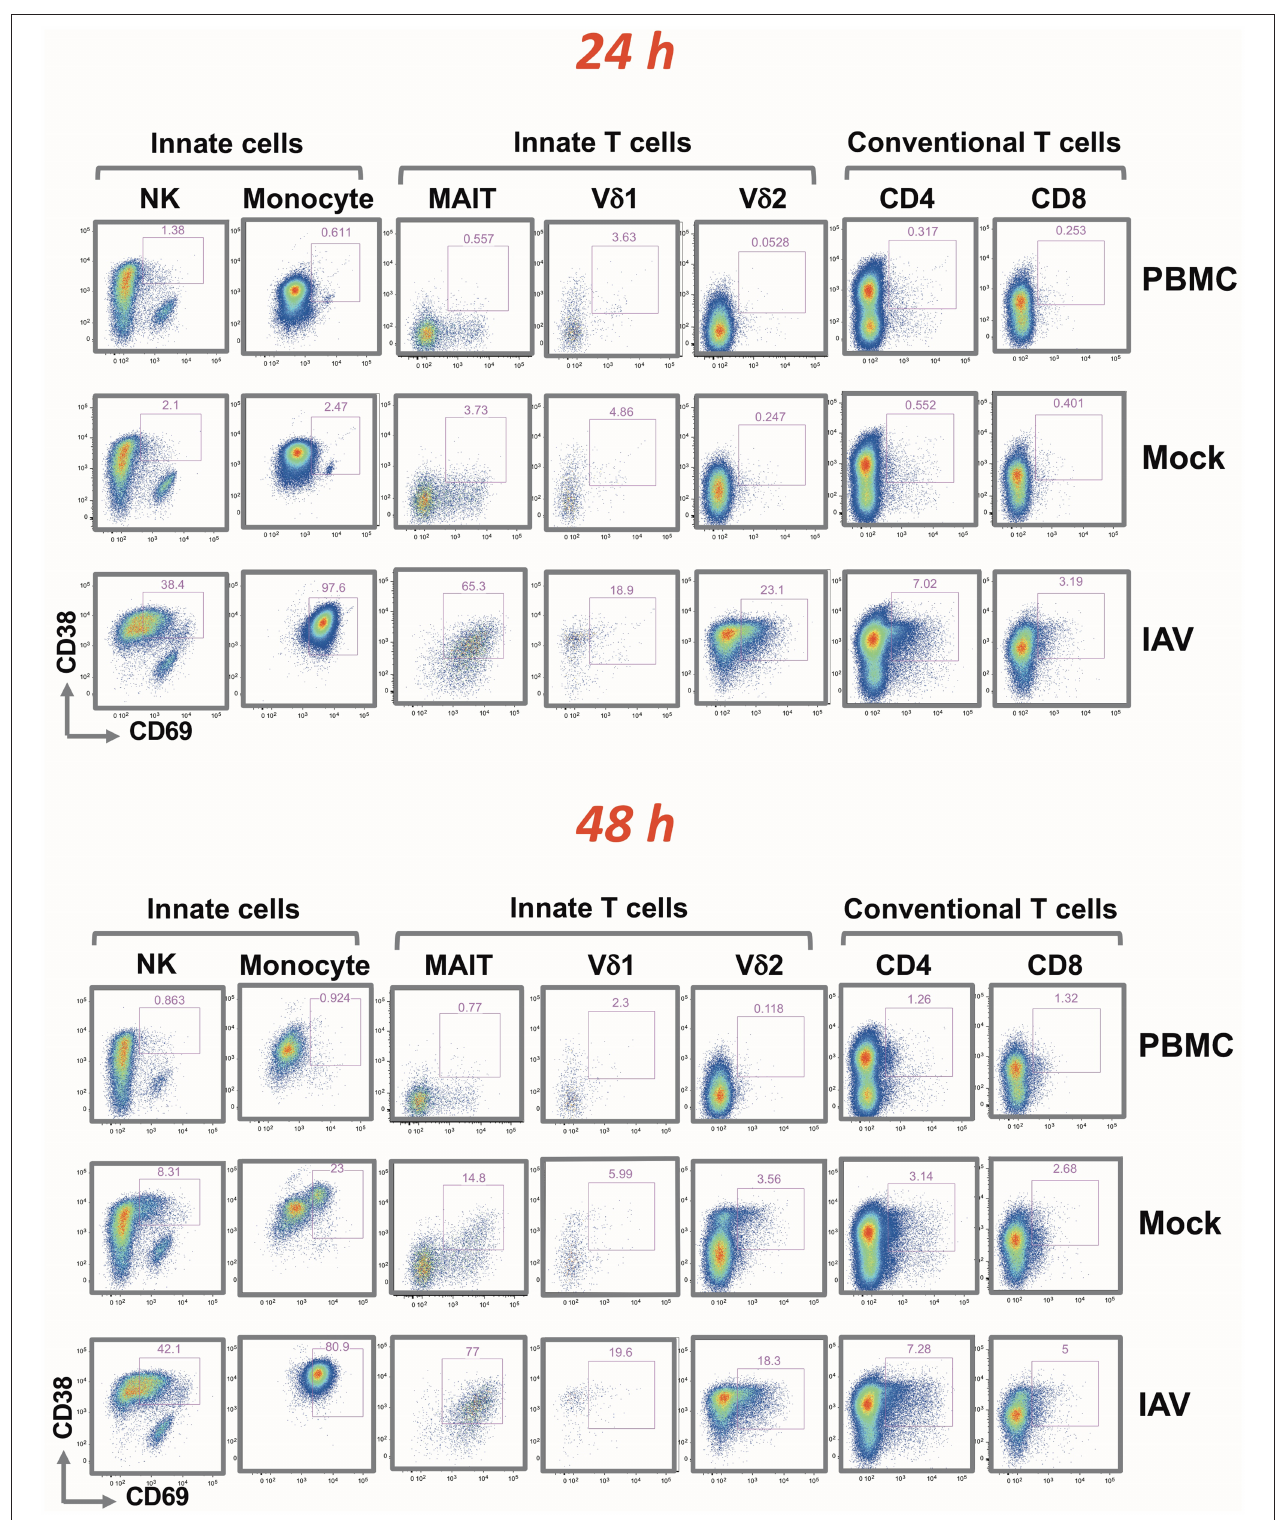
FIGURE 3 | Rapid up-regulation of activation markers by mononuclear cells following H3N2 infection of nasal epithelium . Representation of flow cytometric analysis of CD38 and CD69 up-regulation in NK, monocyte, MAIT, V δ 1, V δ 2T cells, CD4 + , and CD8 + T cells for PBMC only, uninfected epithelium with PBMC, and influenza-infected epithelium with PBMC cultured for 24 and